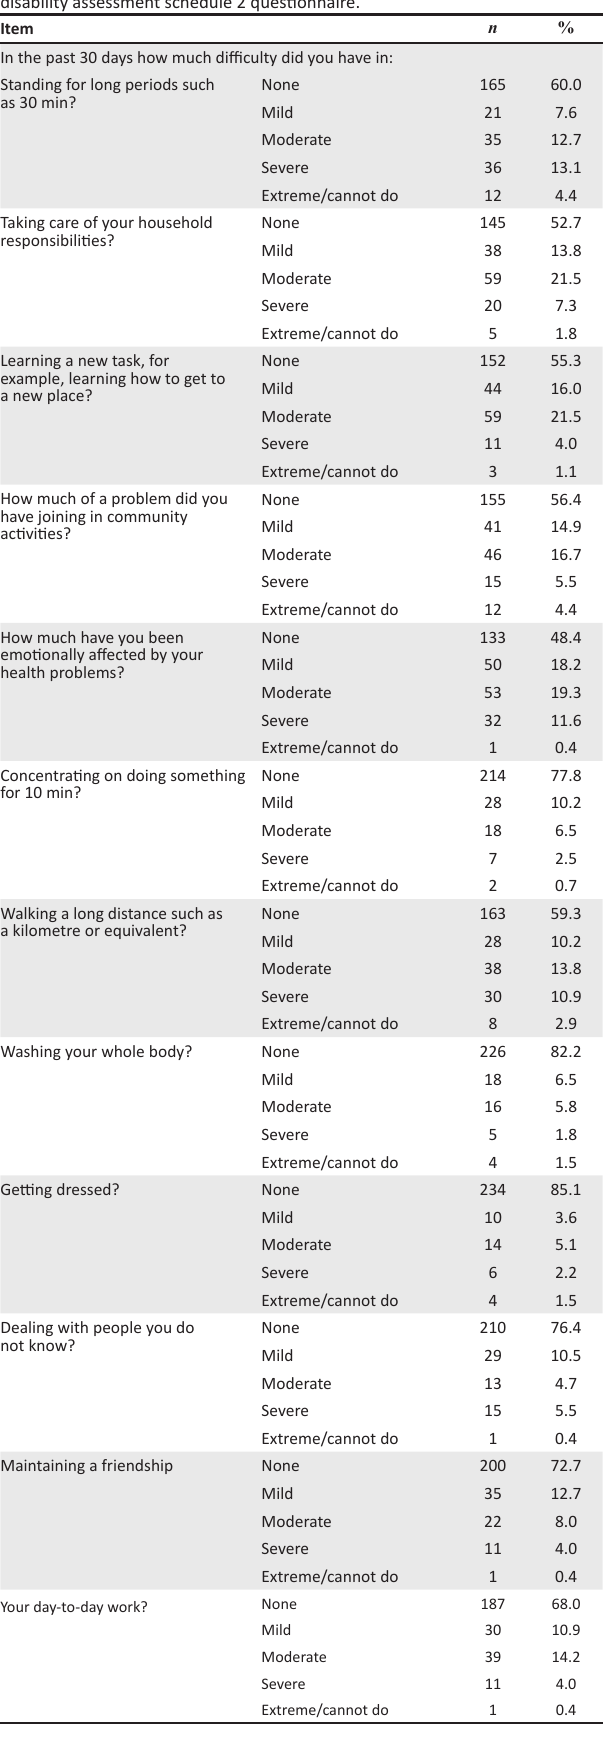
TABLE 5: Responses of members of centres to World Health Organisation disability assessment schedule 2 questionnaire. Item